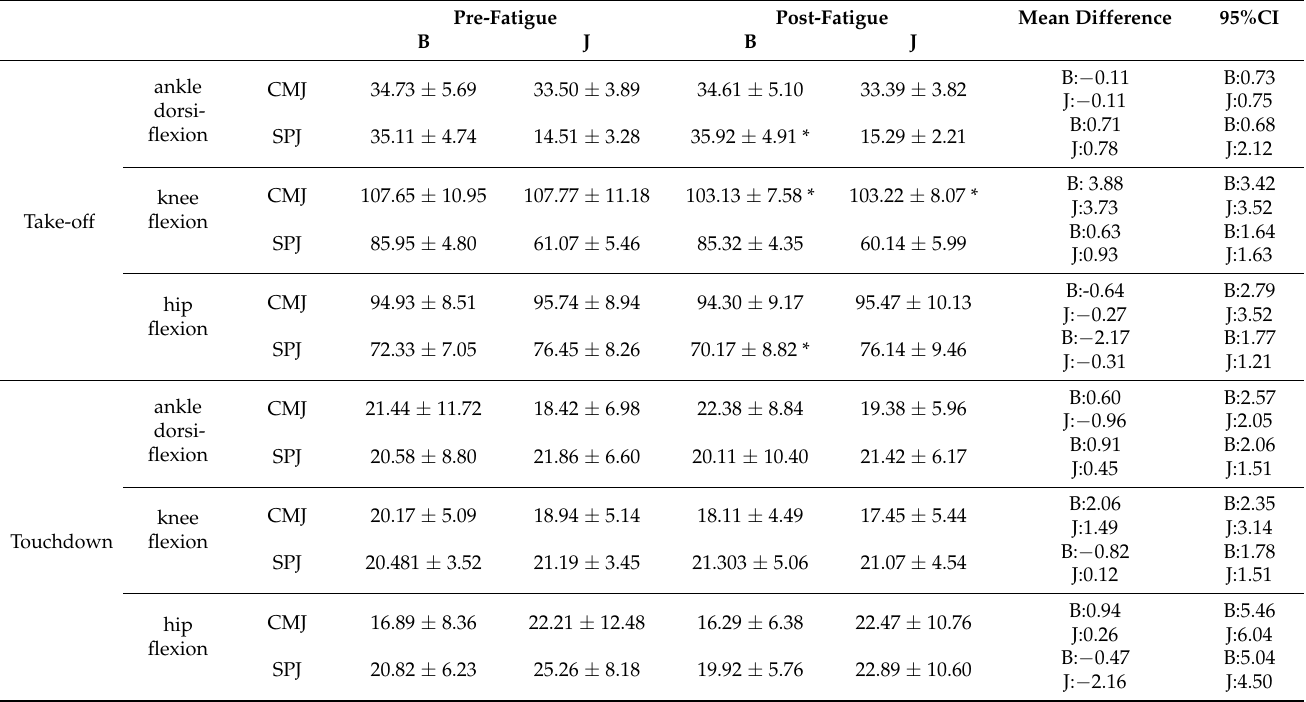
Table 2. The angles of joints at take-off and touchdown ( ◦